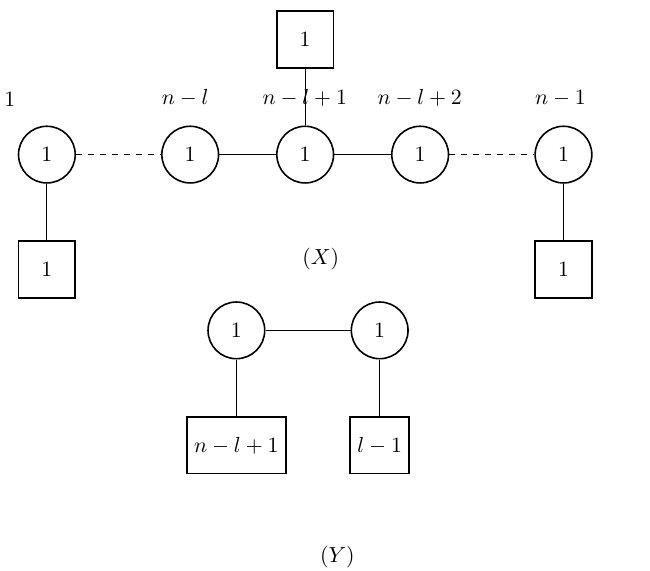
Figure 18 . Pair of linear quivers with U(1) gauge groups which generate the 3d mirrors in figure